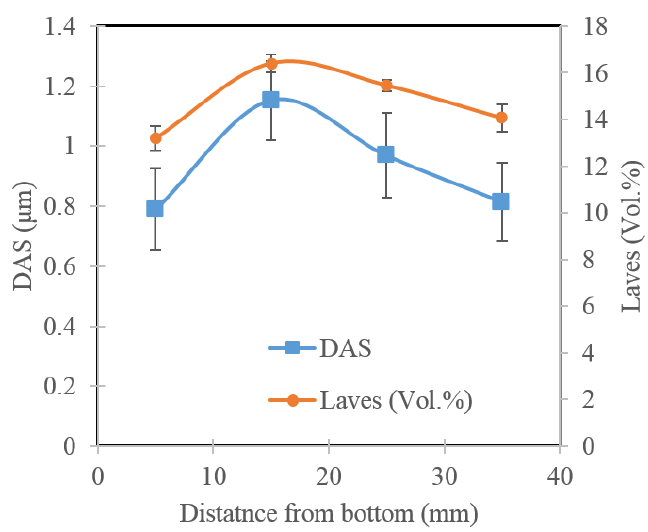
Figure 5. Variation of DAS and Laves phase along the height of the as-SLM IN718 samples.